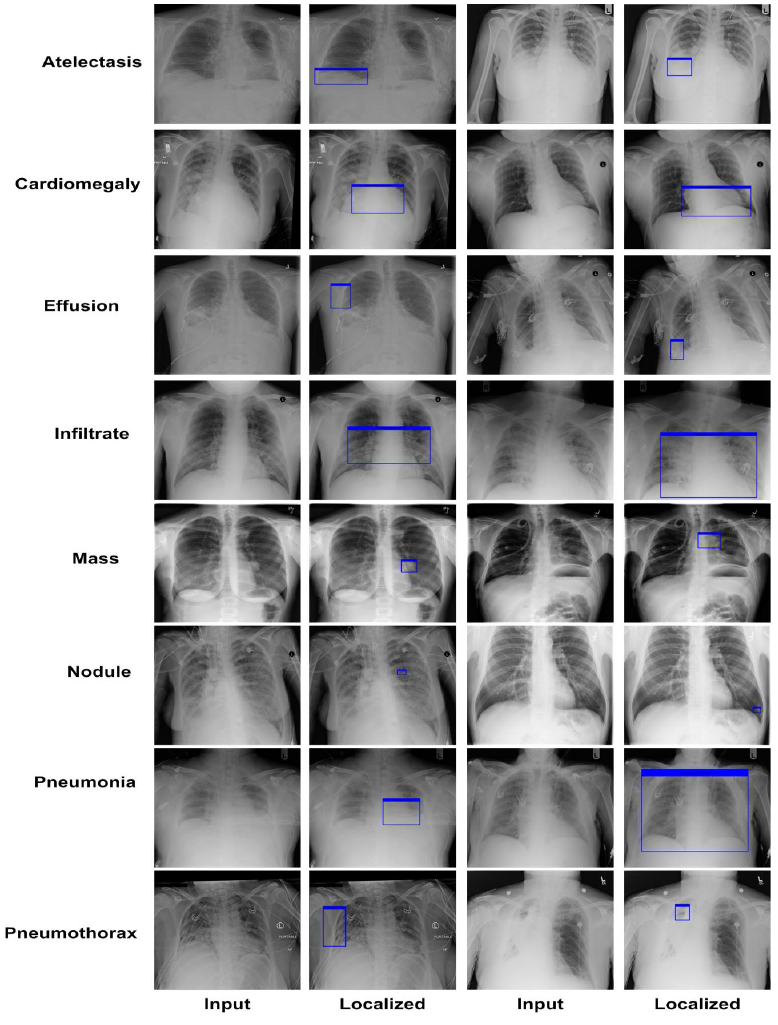
Figure 7. Localization results